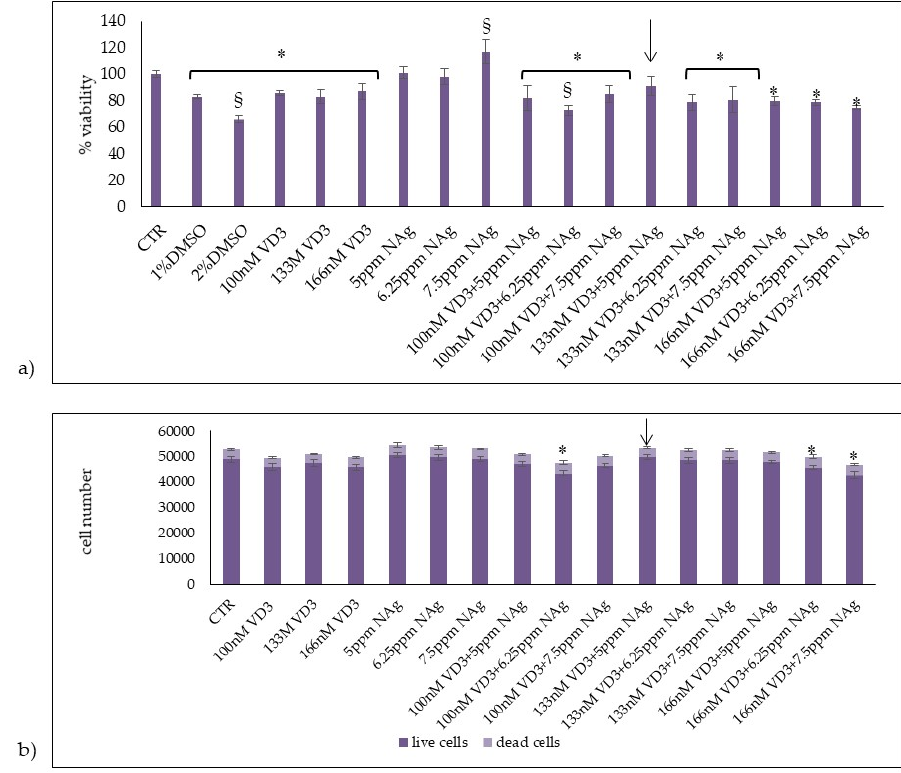
Figure 1. Effect of VD3, AgNPs (NAg), and their combination in HaCaT cells. Cells were cultured and treated as reported in Section 4. ( a ) Cell viability was measured by MTT assay. Values are reported as percentage viability of the control sample; 1% DMSO and 2% DMSO were used as positive controls. ( b ) Live and dead cell number were measured by trypan blue exclusion assay. Data are expressed as mean ± SD of three independent experiments performed in duplicate. Significance, * p < 0.05 versus the control sample analyzed by t test and § p < 0.05 analyzed by ANOVA coupled with Bonferroni post hoc